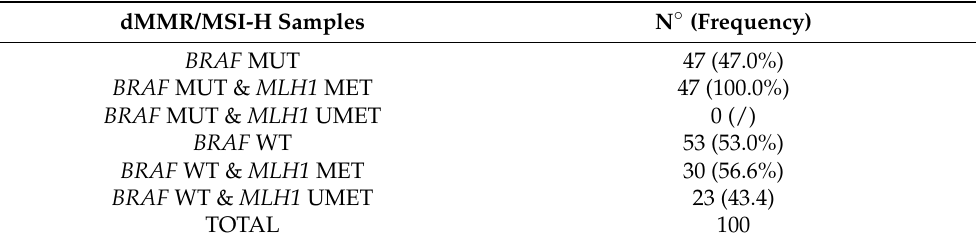
Table 1. Molecular profile according to BRAF mutational status.